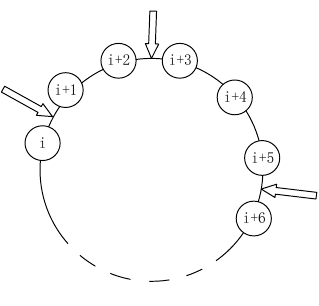
Figure 6. Attacking mode